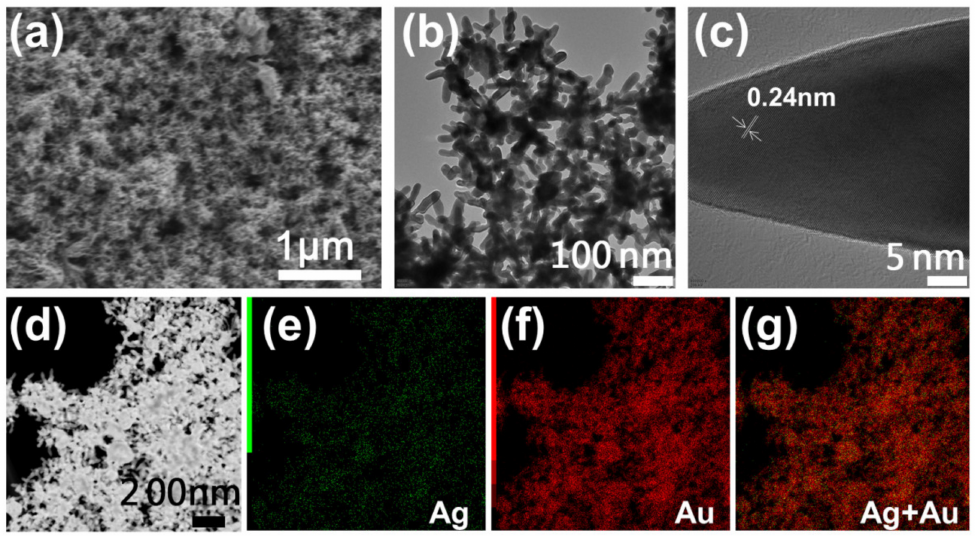
Figure 1. ( a ) SEM, ( b ) TEM, ( c ) HRTEM, and ( d ) HAADF images of as-prepared Ag@Au NPs, when the amount of Ag seed was 40 uL. ( e – g ) The corresponding EDS